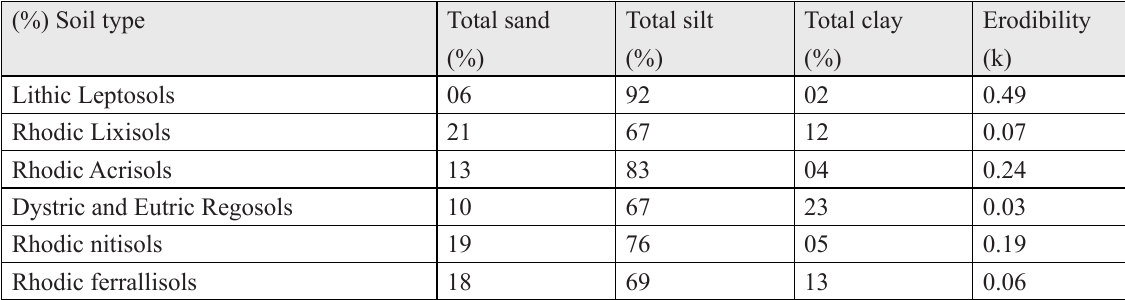
Table 1. Soil erodibility (%) Soil